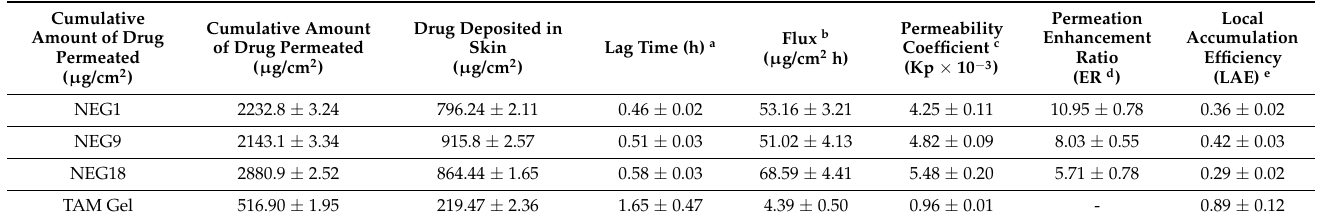
Table 8. TAM drug deposition and permeation data from three optimised TAM-NEGs and TAM